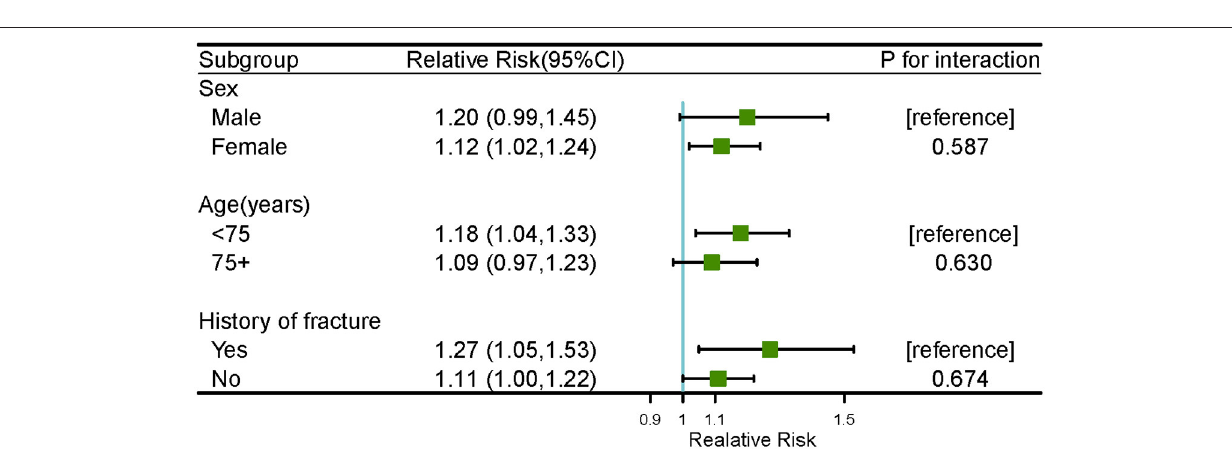
history of fracture subgroups ( P for interaction were 0.587, 0.630, and 0.674,